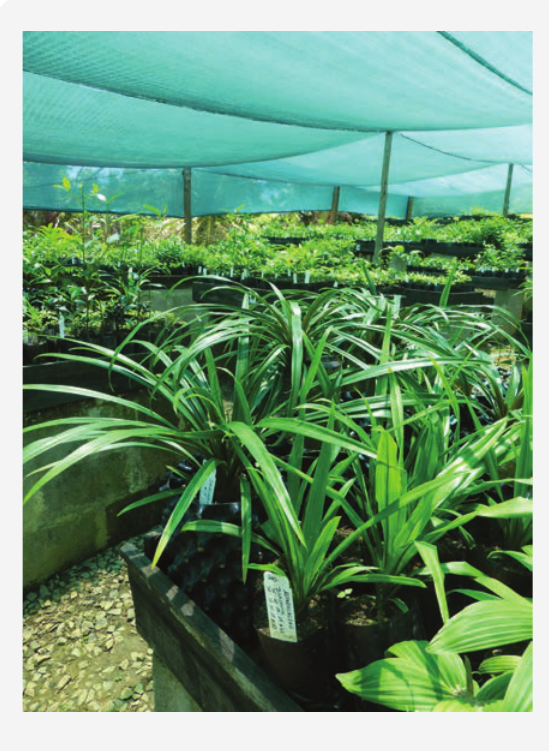
Figure 7. Plants of Dracaena umbraculifera growing in ex situ cultivation in Madagascar. After rediscovery of the species, seeds have been collected from unprotected populations. Plants are be- ing grown for future reintroductions into protected sites. Photo by Chris Birkinshaw